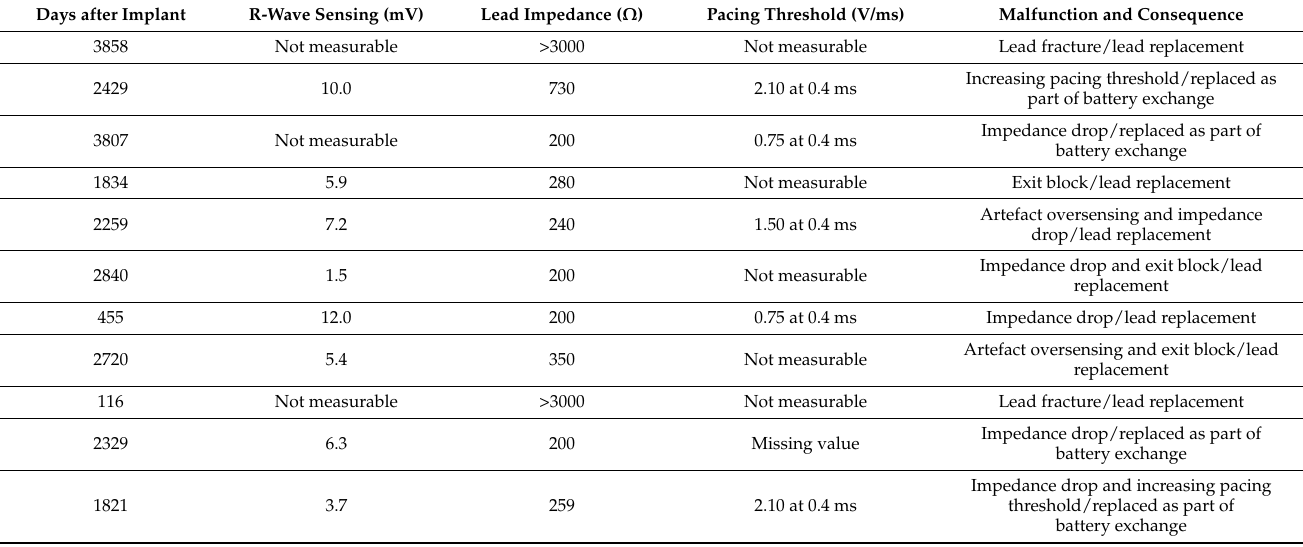
Table 4. Characteristics of patients with lead